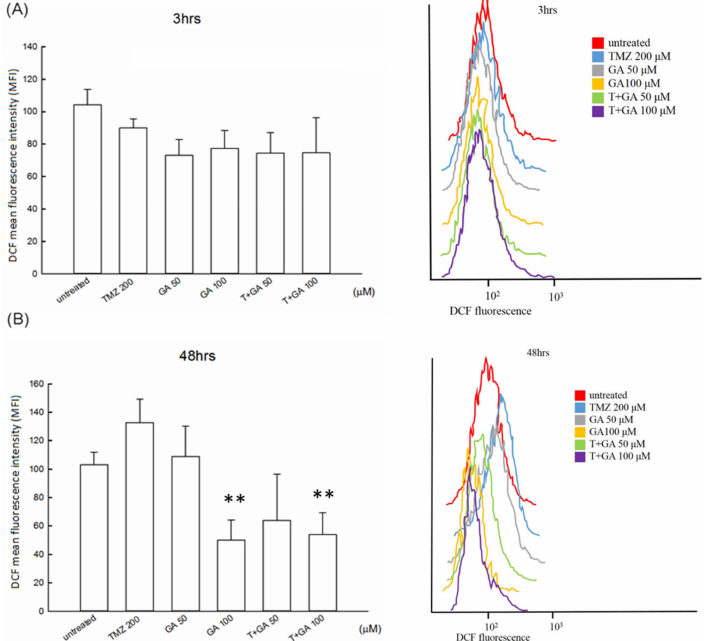
Figure 5. Detection of intracellular ROS in TMZ, Ga or Ga and TMZ co-incubation. A total of 1 × 10 6 U87MG cells were cultured in 6 cm cultured dishes for 24 h, incubated with 200 µ M TMZ, 50 or 100 µ M Ga or co-incubated with both for 3 or 48 h. After incubation, all cells were incubated with DCFDA for intracellular ROS detection and determined by a flow cytometer. ( A ) Data show the MFI inside the cells. The data are shown as mean ± SD ( n = 5–8) of individual experiments. Significant difference is p < 0.01 (**) compared with untreated group. ( B ) The overlay plots of DCF flow cytometry